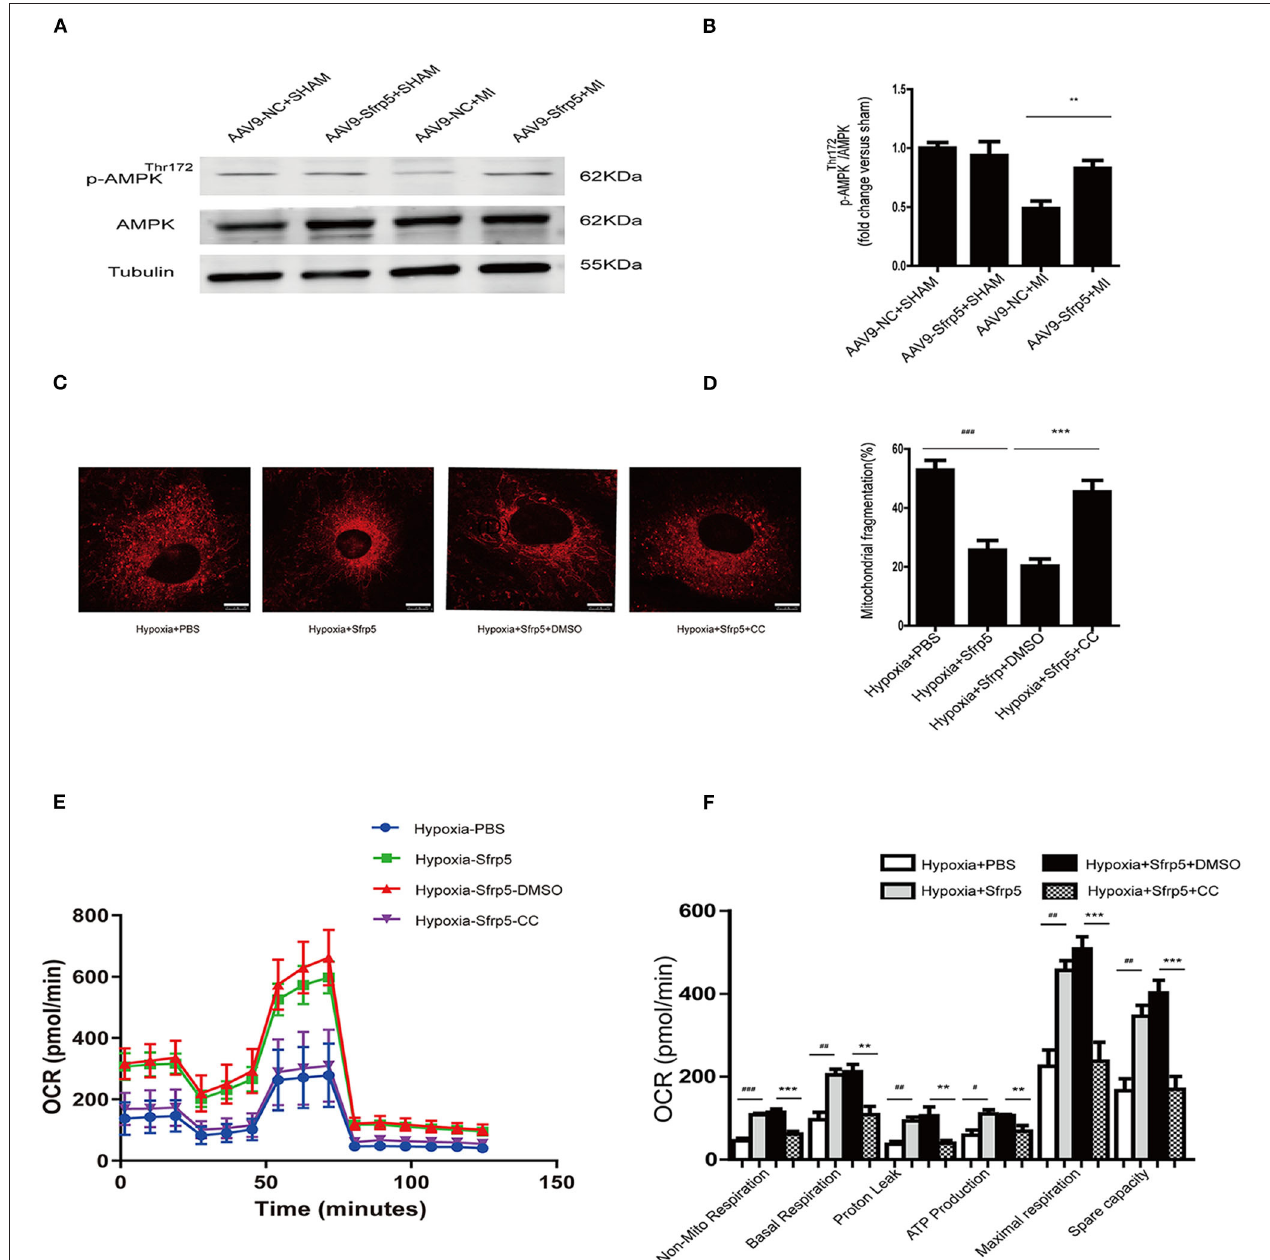
FIGURE 6 | Sfrp5 preserves mitochondrial function partly through the AMPK pathway. (A) Protein expression of AMPK in mouse hearts at 14 days after MI ( n = 4 per group). (B) Quantitative analysis of the relative p-AMPK Thr172 /AMPK. (C) Mitochondrial morphology was detected by Mito-Tracker staining. Scale bars = 10 µ m. (D) Quantitative analysis of mitochondrial fragmentation. (E) Representative images of OCR in Sfrp5-treated, PBS-treated, Sfrp5 + Compound C-treated and Sfrp5 + DMSO-treated neonatal rat cardiac myocyte cells under hypoxia conditions as analyzed by the Seahorse XF. (F) Quantitative analysis of mitochondrial respiration calculated from the OCR trace in E . ** p < 0.01 AAV9-NC + MI mice at 14 days after MI vs. AAV9-Sfrp5 + MI mice at 14 days after MI. # p < 0.05 Hypoxia + PBS group vs. Hypoxia + Sfrp5. ## p < 0.01 Hypoxia + PBS group vs. Hypoxia + Sfrp5. ### p < 0.001 Hypoxia + PBS group vs. Hypoxia + Sfrp5. ** p < 0.01 Hypoxia + Sfrp5 + DMSO group vs. Hypoxia + Sfrp5 + CC. *** p < 0.001 Hypoxia + Sfrp5 + DMSO group vs. Hypoxia + Sfrp5 + CC.